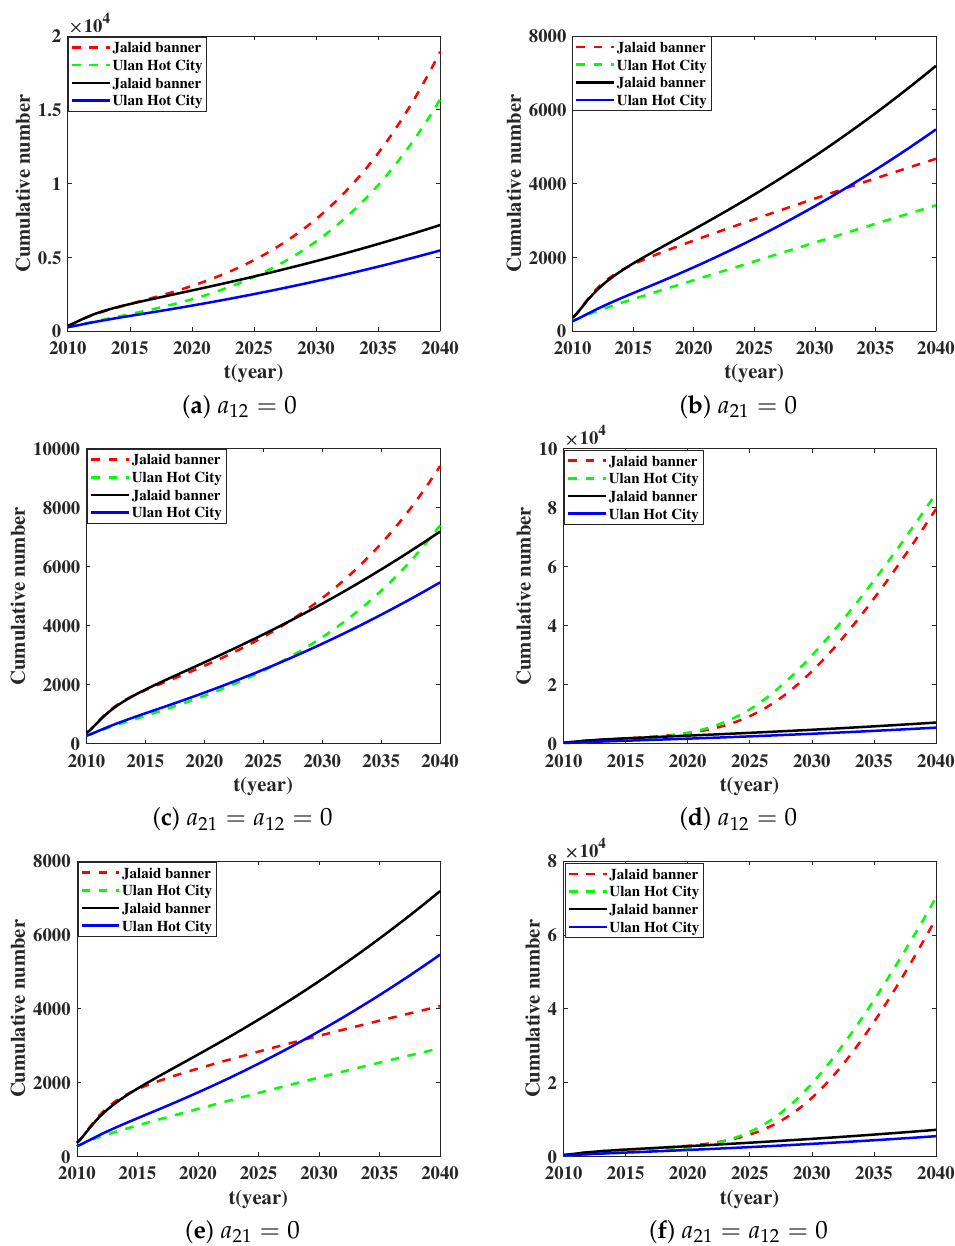
Figure 6. Cumulative number versus time t . Solid lines represent the solution of System (1). In ( a – c ), the dotted line represents three cases: zero transportation rate of infected sheep in one direction ( a 12 = 0 or a 21 = 0) and zero transportation rate of infected sheep in two directions ( a 21 = a 12 = 0). In ( d – f ), the dotted line represents three cases: zero transportation rate of exposed, infected sheep and brucella in the environment in one direction ( a 12 = 0 or a 21 = 0) and zero transportation rate of exposed, infected sheep and brucella in the environment in two directions ( a 21 = a 12 =